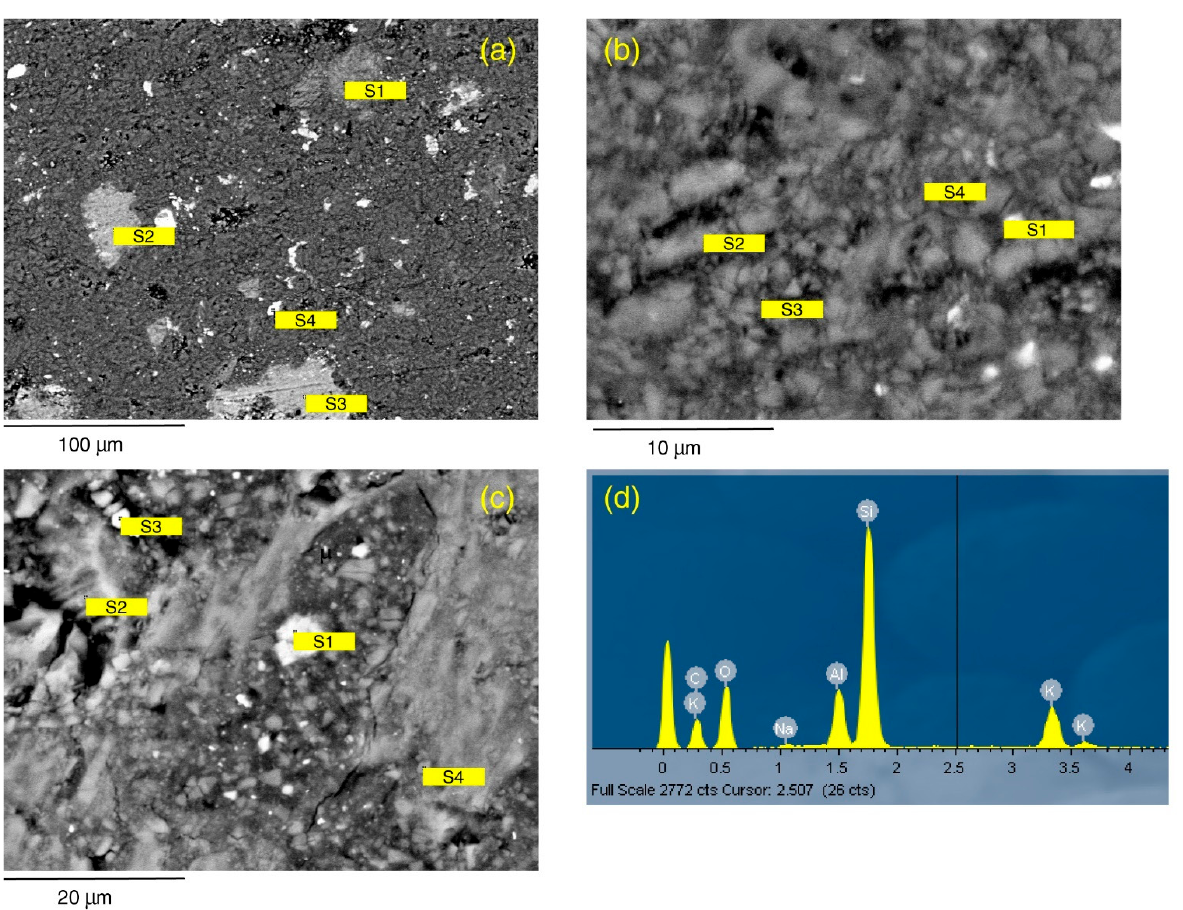
Figure 6. SEM-EDS data of C1 sample in thin section. ( a ) General aspect at low magnification scale at the analytical Site 1. S1: muscovite with quartz; S2 and S3: solid solution of Fe-rich dolomite and ankerite; S4: anatase. ( b ) Texture and mineralogy of the analytical Site S2. S1: Fe-rich illite; S2 and S3: quartz; S4: illite. ( c ) Texture and mineralogy of the analytical Site 3. S1: solid solution of siderite-ankerite; S2: kaolinite with adsorbed Na from underlying primary plagioclase; S3: solid solution of